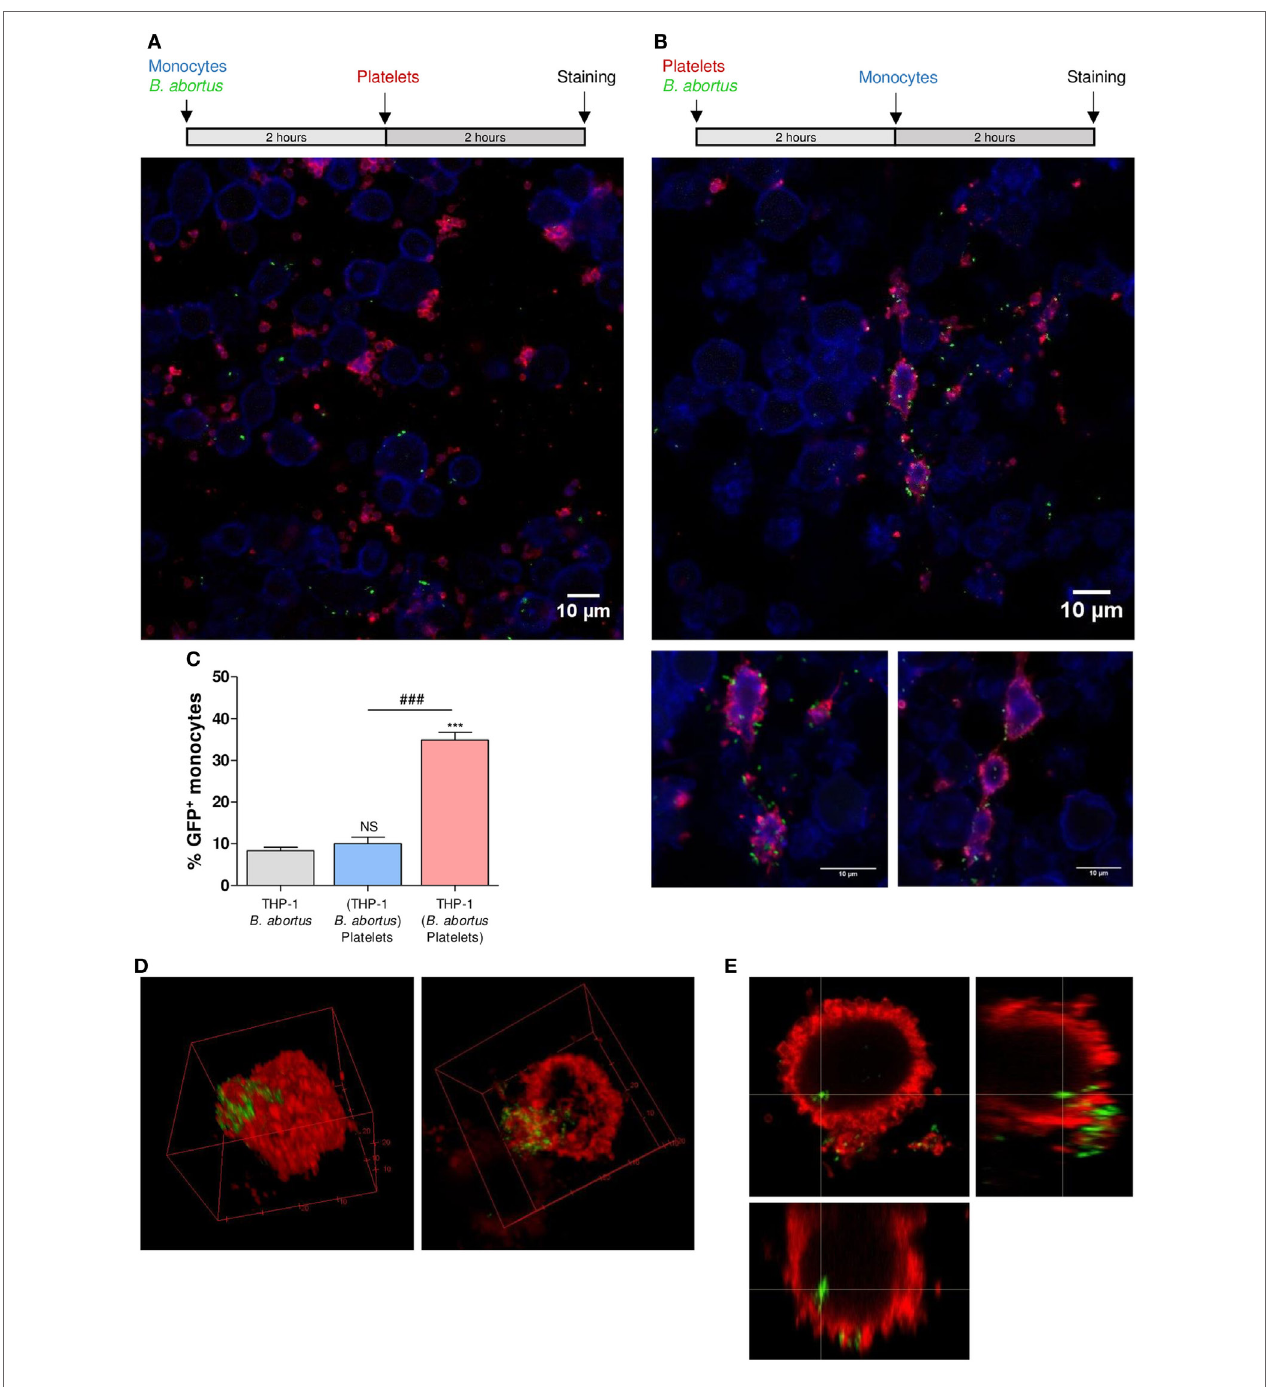
FigUre 5 | Platelets act as carriers of bacteria toward monocytes. (a) Confocal micrographs of THP-1 cells incubated with green fluorescence protein (GFP)- Brucella abortus for 2 h and then incubated with platelets for additional 2 h. (B) Platelets were incubated with GFP- B. abortus for 2 h. THP-1 cells were then incubated with this suspension for additional 2 h. Monocyte population was stained with an anti-human MHC-I primary Ab and Alexa-633-labeled secondary Ab (blue). Platelet population was stained with an anti-human CD61 primary Ab and Alexa-546-labeled secondary Ab (red). Results are representative of three independent experiments. THP-1:PTL: Ba 1:100:100. (c) Quantification of THP-1 cell invasion by B. abortus for three experimental conditions: B. abortus -infected monocytes in absence of platelets and experimental conditions shown in panels (a,B) . Data are expressed as the percentage of monocytes invaded (GFP-positive monocytes) ± SEM of three independent experiments. The number of cells counted per experimental group was 200. NS, not significant; *** P < 0.001 vs. THP-1 + B. abortus ; ### P < 0.001. (D,e) Platelets were incubated with GFP- B. abortus for 2 h. THP-1 cells were then incubated with this suspension for additional 2 h. Platelets were stained with an anti-human CD61 primary Ab and Alexa-546-labeled secondary Ab (red). 3D reconstruction (D) ; and Merge Z-stack and orthogonal view (e)